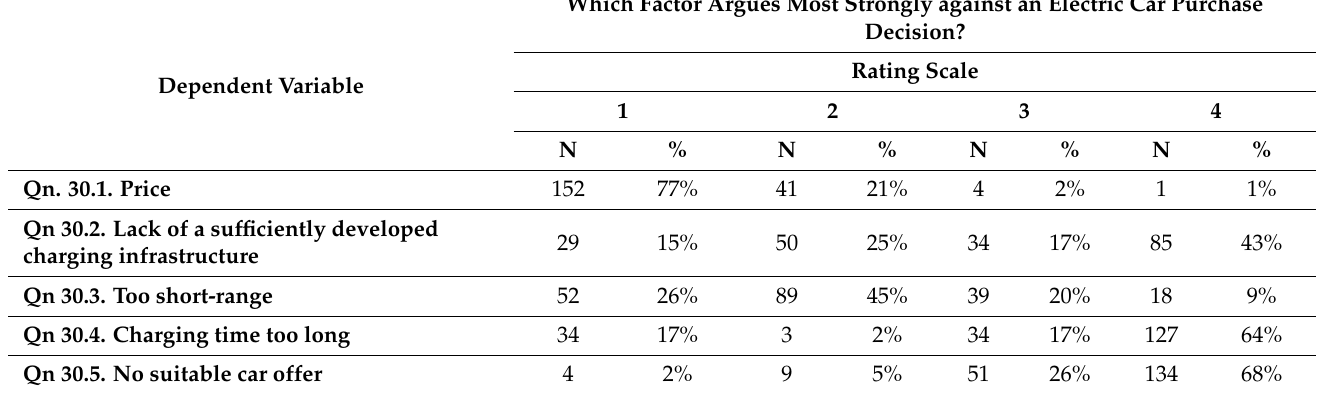
Table 9. Factors adversely affecting EV purchase